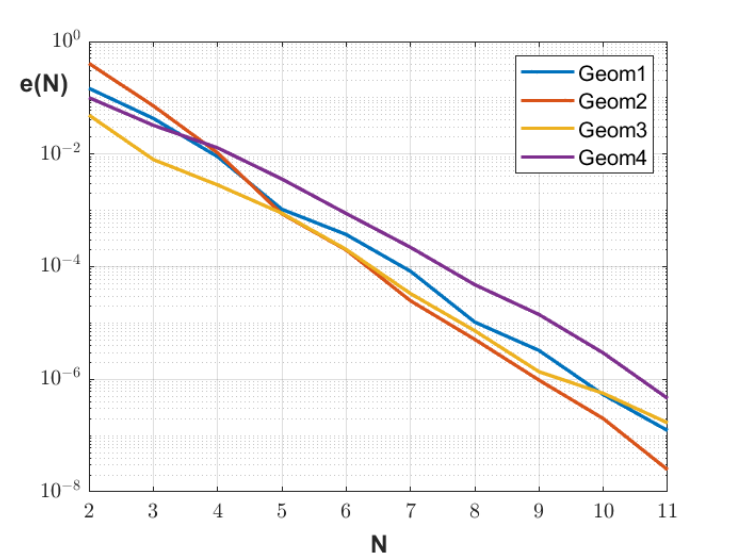
Figure 2. Plot of the error for the geometries of Table 1 for TE incidence and an incidence angle θ inc = 45 ◦ .